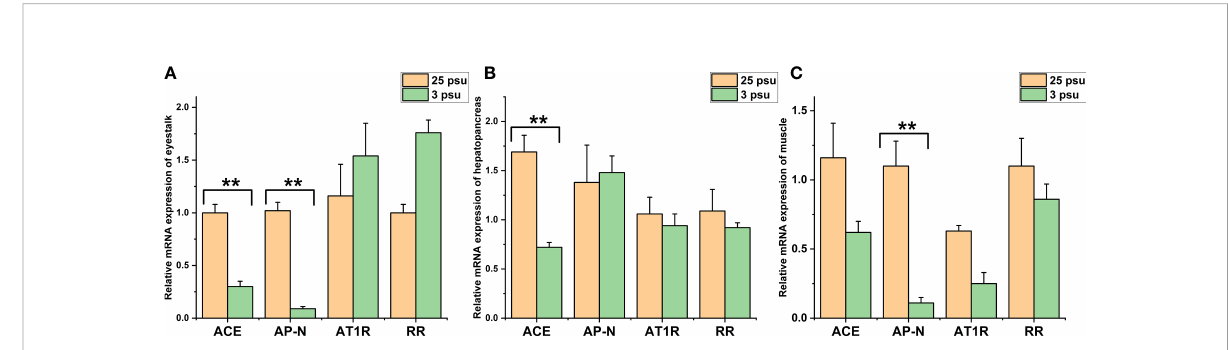
FIGURE 6 The expression levels of LV-ACE , LV-APN , LV-AT 1 R , and LV-RR in the eyestalk (A) , hepatopancreas (B) , and muscle (C) under long-term low salinity stress. Signi fi cant differences are indicated with ** marks ( P < 0.05). Values are the mean ( ± SD). (N =